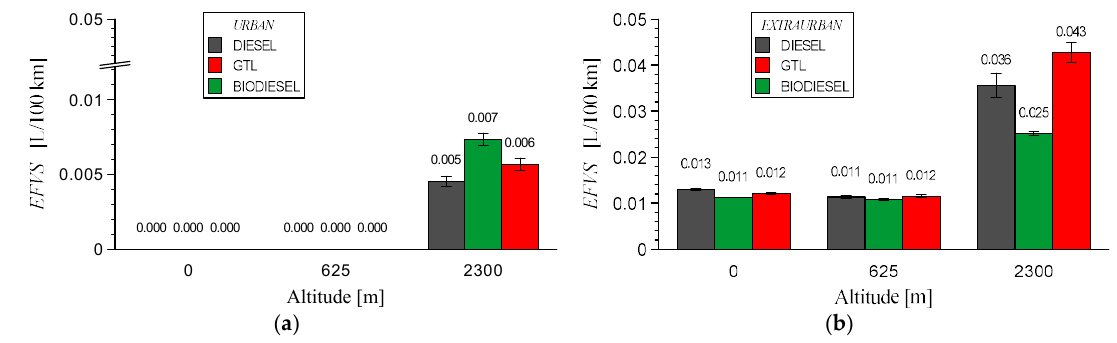
Figure 12. Estimated fuel volume savings: ( a ) Urban driving conditions, ( b ) Extra-urban driving conditions.